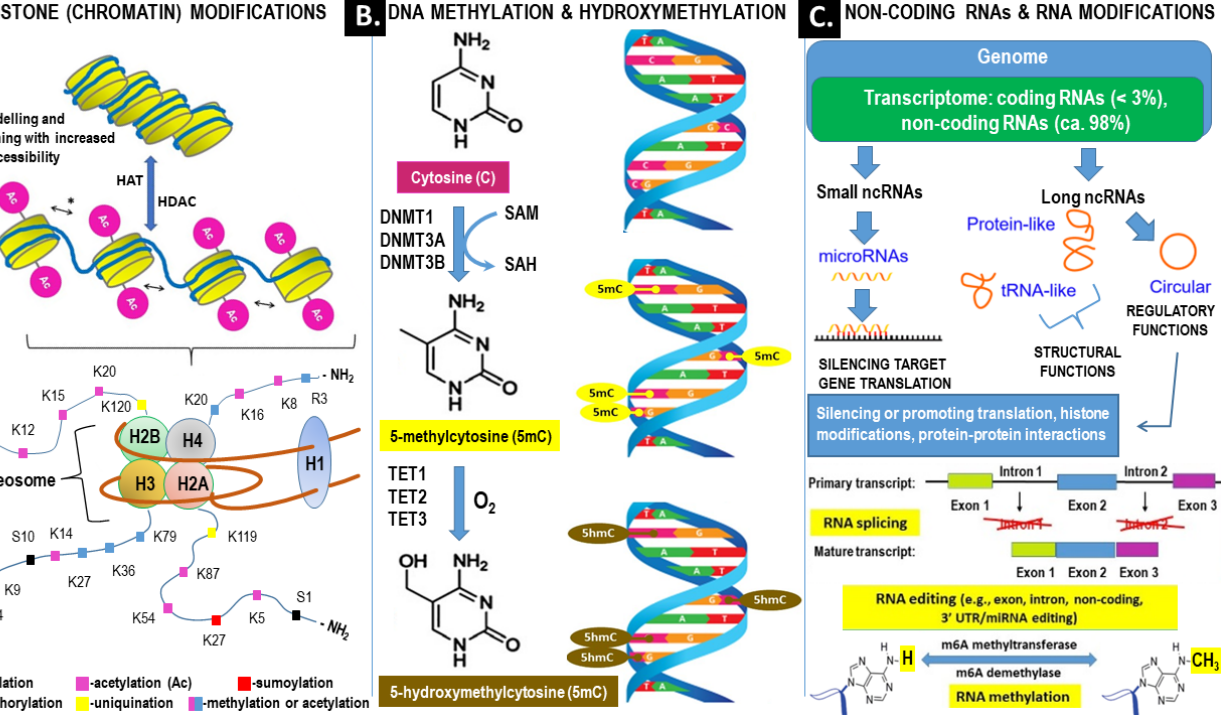
Figure 2. Overview of the main epigenetic mechanisms that regulate gene expression and may establish potentially heritable changes in gene expression without altering the underlying DNA nucleotide sequence. ( A ) Histone (chromatin) modifications. At the top. Chromatin remodeling is the dynamic modification of chromatin architecture to allow access of condensed genomic DNA to the regulatory transcription machinery proteins, and thereby control gene expression. For example, histone acetylation by HAT (histone acetyl transferase) increases DNA (chromatin) accessibility because acetylated